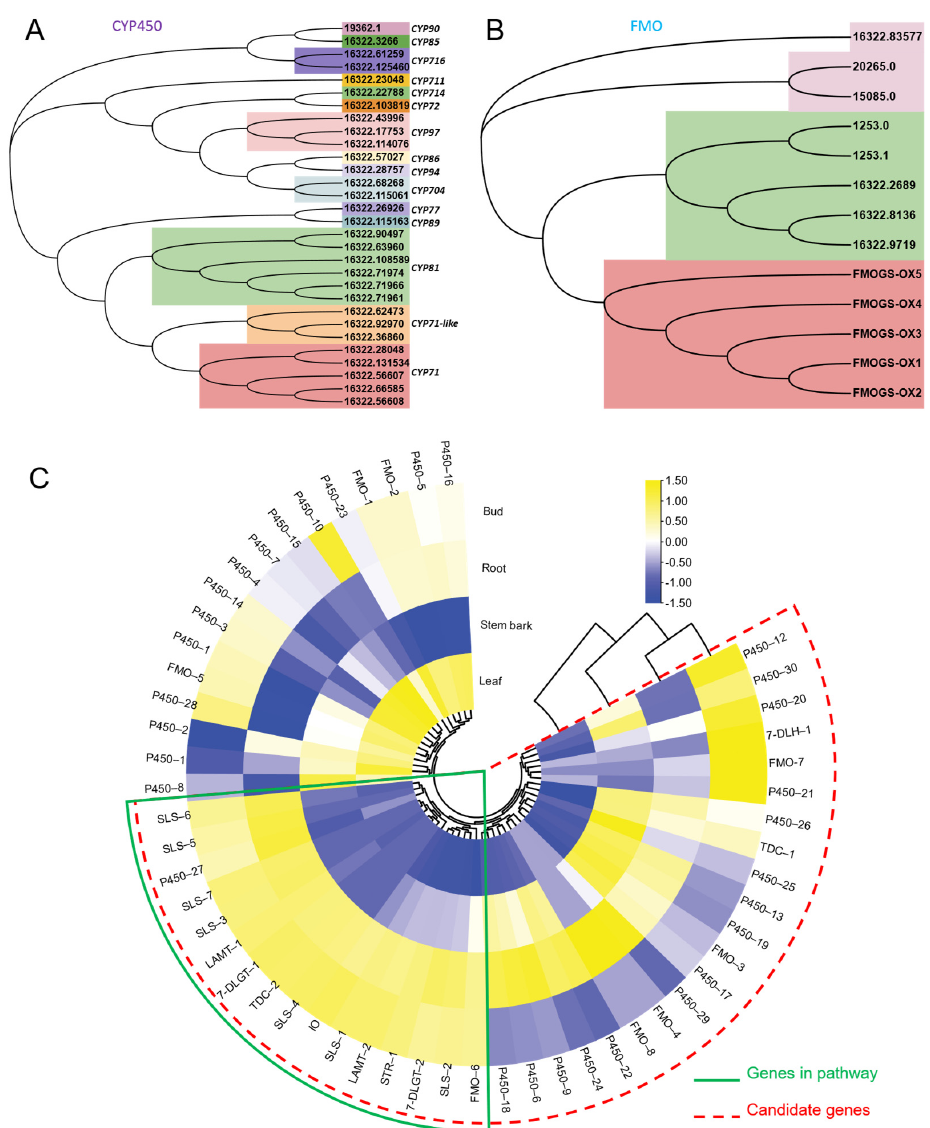
Figure 9. Candidate CYP450s and FMOs involved in spiroindole alkaloids. Phylogenetic analysis of CYP450s ( A ) and FMOs ( B ). ( C ) the co-expression analysis of candidate CYP450s and FMOs.